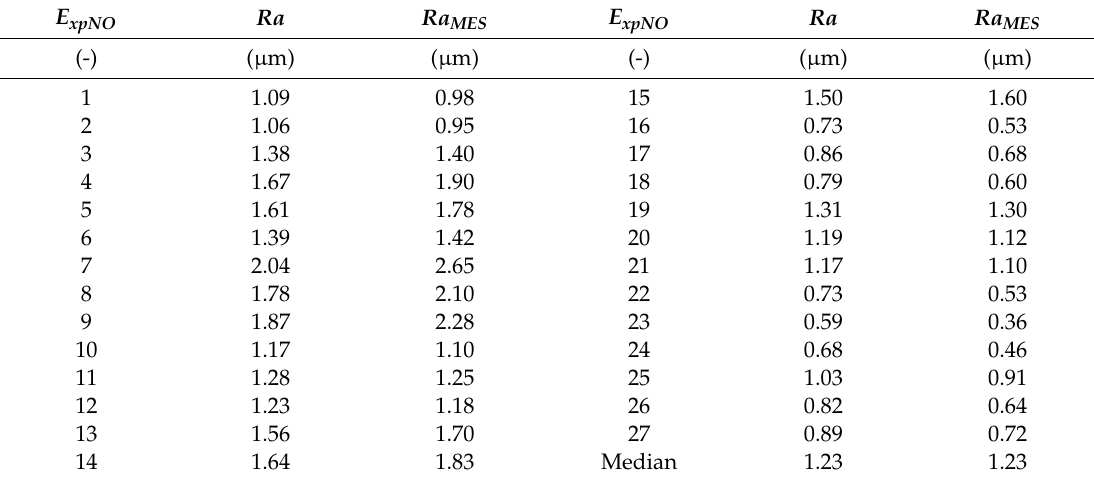
Table 9. Comparation and Verification